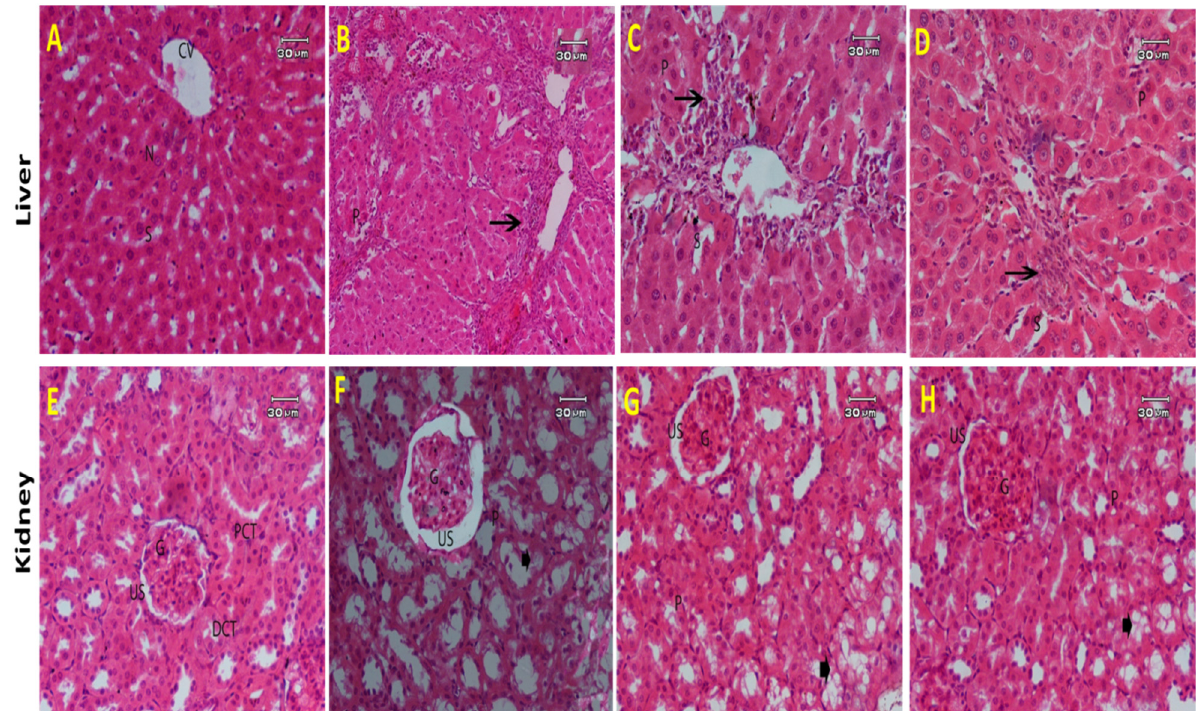
Figure 8. A photomicrograph of ( A ) rat liver of control group showing normal hepatic architecture. Central vein (CV), blood sinusoids (S) and nucleus (N) are found; ( B ) rat liver intoxicated by TAA showing disorganized hepatocytes, fibrosis with inflammatory cell proliferation in between the congested portal vein, aggregation of inflammatory cells (arrow), bridging of fibroblast-like cells, degeneration changes with cytoplasmic necrotic areas, and deeply pyknotic nuclei, (H & E stain, Scale bar: 60 µ m); ( C ) liver from rats administered TAA and 50 mg/kg b.w. of CLEE showing mild to moderate fibrosis with thin bridging fibroblasts, inflammatory cell infiltration around central vein (arrow), degeneration, mild necrosis (arrowhead), dilated sinusoids (S), and pyknotic nuclei (P); and ( D ): liver from rats administered TAA with 100 mg /kg b.w. of CLEE showing few degenerative hepatocytes with less fibrosis and thin bridging fibroblasts, dilated sinusoids (S), and pyknotic nuclei; ( E ) kidney section of control group showing normal structure of the glomerulus (G), urinary space (US), Proximal convoluted tubule (PCT) and distal convoluted tubule (DCT) ; ( F ) kidney section of rats intoxicated by TAA, showing shrunken glomeruli ( G ) with dilated capsular spaces (US), tubular epithelial cell degeneration, and necrosis associated with pyknotic nuclei (P); ( G ) kidney section of rats administered TAA and 50 mg/kg b.w. of CLEE showing moderated degeneration (arrow head), pyknotic nuclei (P) observed in tubules epithelial cells; ( H ) kidney section of rats administered TAA and 100 mg/kg b.w. of CLEE showing improved degeneration of tubules (arrow head) and pyknotic nuclei (P). (H & E stain, Scale bar: 30 µ